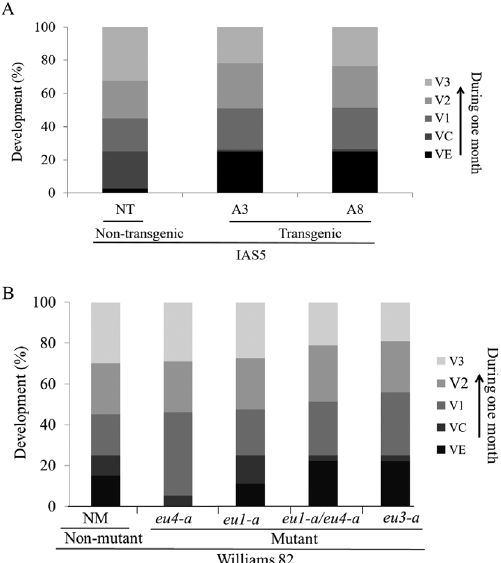
Figure 2 - Plant developmental pattern over the first month after germina- tion. (A) Transgenic and non-transgenic plants were evaluated: 18 plants derived from each event (A3 and A8) and 10 non-transgenic plants. (B) eu4-a, eu1-a, eu1-a/eu4-a and eu3-a mutant and non-mutant plants were evaluated: 18 plants from each mutant and 10 non-mutant plants. Plants were classified according categories: VE= emergence of cotyledons; VC= completely opened cotyledons; V1 = completely developed unifoliate leaf pair; V2= completely developed first trifoliate leaf; V3= completely de- veloped second trifoliate leaf. A generalized linear model for repeated measures was used to compare the plant development among genotypes (p < 0.01).